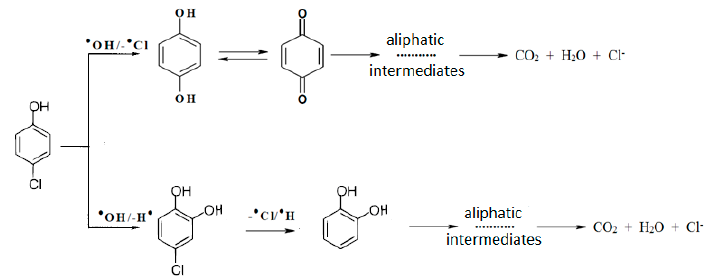
Figure 8. Speculative photocatalytic degradation pathways of 2,4-chlorophenol.